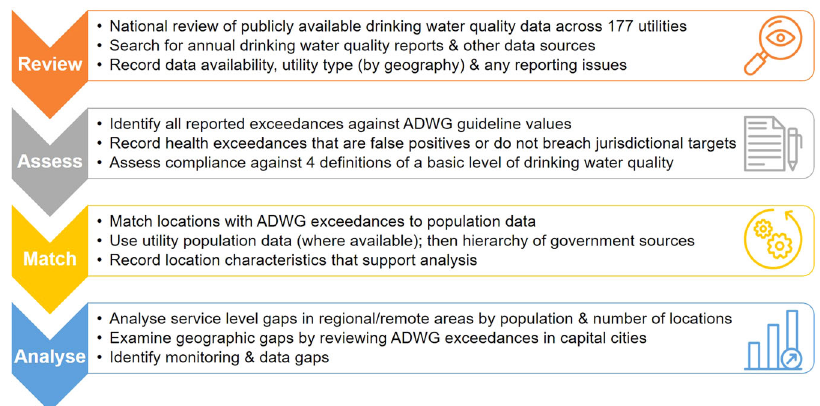
Fig. 7 Methodology to construct dataset of ADWG exceedances and estimate populations and locations lacking access to basic levels of service. Icons downloaded from the Noun Project (https://thenounproject.com/) using a using a NounPro for EDU